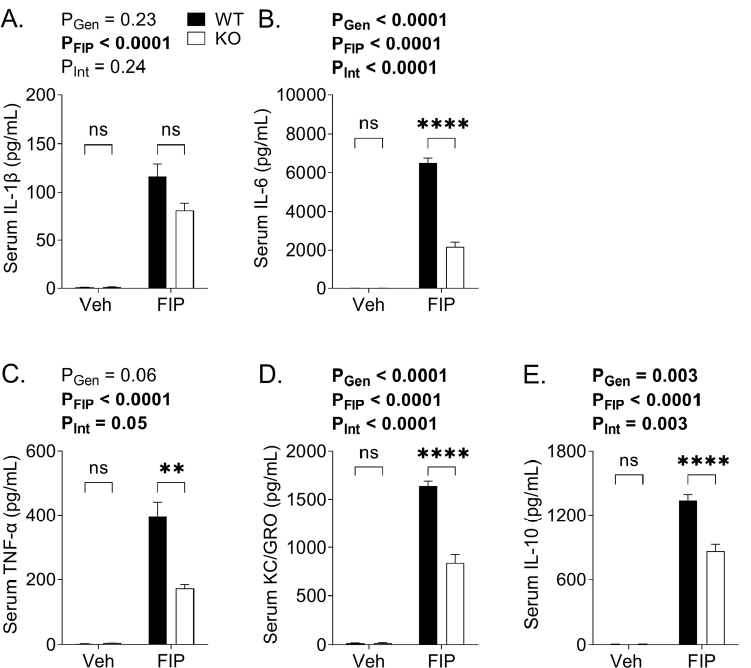
Figure 3. Serum cytokine profiles in wild-type (WT) and OSMR type II receptor knockout (KO) mice subjected to fecal slurry (FS)-induced peritonitis (FIP) or treated with vehicle (veh). Serum collected 18 h post-injection of Veh or FS was analyzed for the levels of ( A ) IL-1 β , ( B ) IL-6, ( C ) tumor necrosis factor alpha (TNF α ), ( D ) keratinocyte chemoattractant (KC)/human growth-related oncogene (GRO), and ( E ) IL-10. The p values reflect the outcomes of 2-way analysis of variance; Sidak post-hoc test outcomes are shown as ** p < 0.01, **** p < 0.0001, ns not significant. Each bar represents n = 3–13